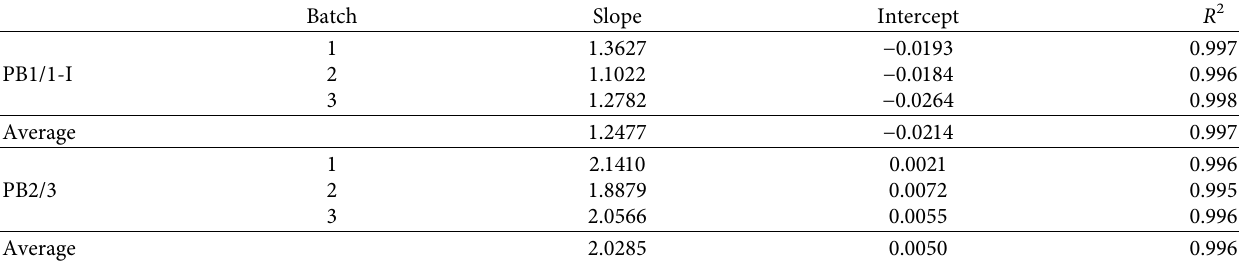
Table 2: Te calibration curve of PB.